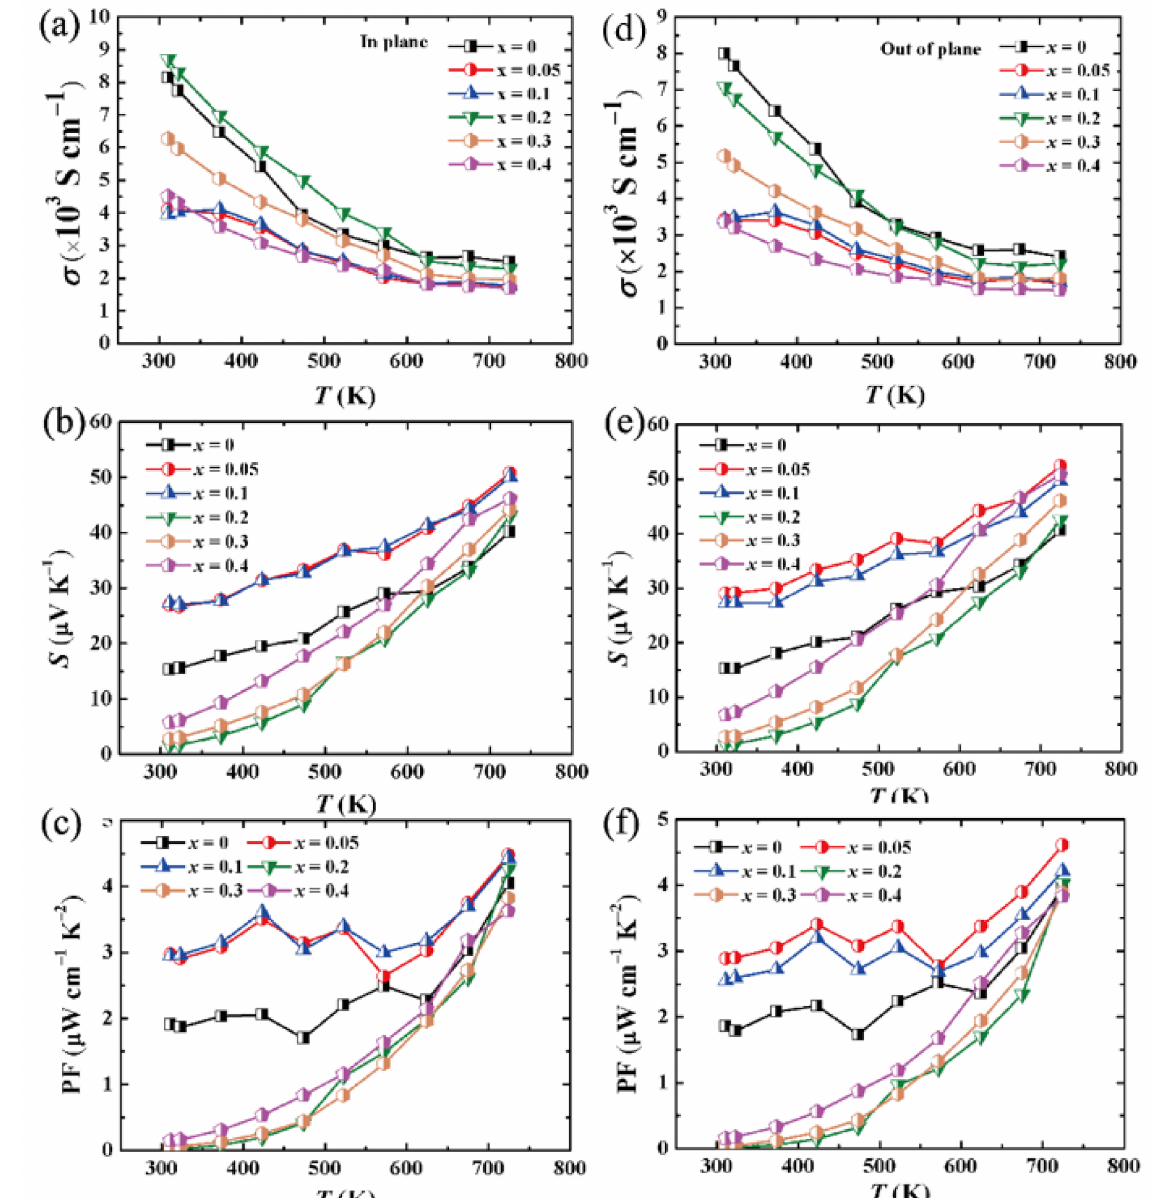
Figure 4. In plane electrical properties of (Cu 2 Te) 1 − x -(BiCuTeO) x : ( a ) electrical conductivity, ( b ) Seebeck coefficient, ( c ) power factor. Electrical properties of (Cu 2 Te) 1 − x -(BiCuTeO) x ; out-of-plane electrical properties of (Cu 2 Te) 1 − x -(BiCuTeO) x : ( d ) electrical conductivity, ( e ) Seebeck coefficient, ( f )